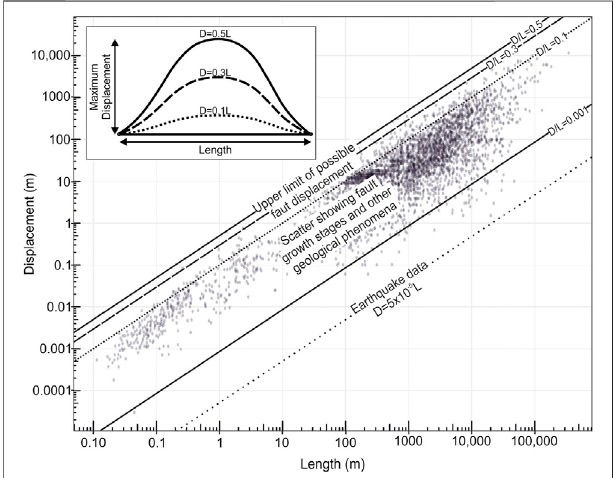
FIGURE 14 | Global D/L dataset for normal faults with our suggested upper limit of D/L (D/L=0.1). The average D/L value of a single earthquake is also shown (Wells and Coppersmith,